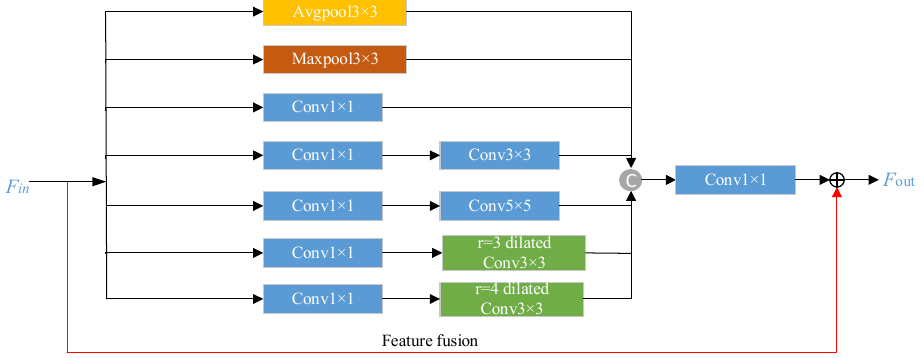
Figure 3. Multiscale feature extraction module.